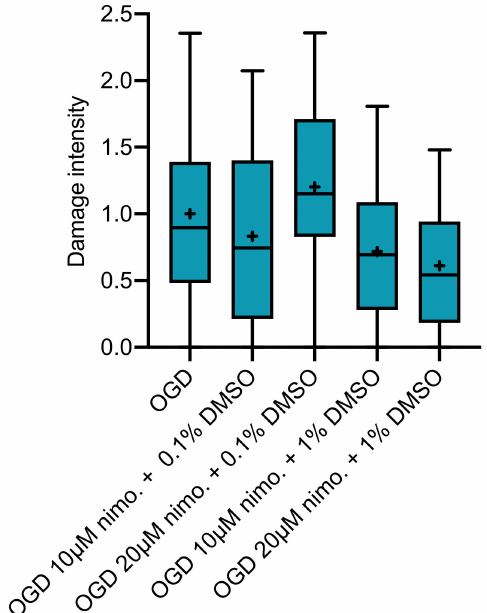
Figure 3. Slices undergoing OGD received nimodipine at either 10 or 20 µ M dissolved in 0.1 or 1.0 Vol.% DMSO. No significant di ff erences in cell damage were observed at 72 h after OGD (OGD n = 96; dissolved in 0.1 Vol.% DMSO: 10 µ M nimodipine n = 77, 20 µ M nimodipine n = 64; dissolved in 1.0 Vol.% DMSO: 10 µ M nimodipine n = 30, 20 µ M nimodipine n =